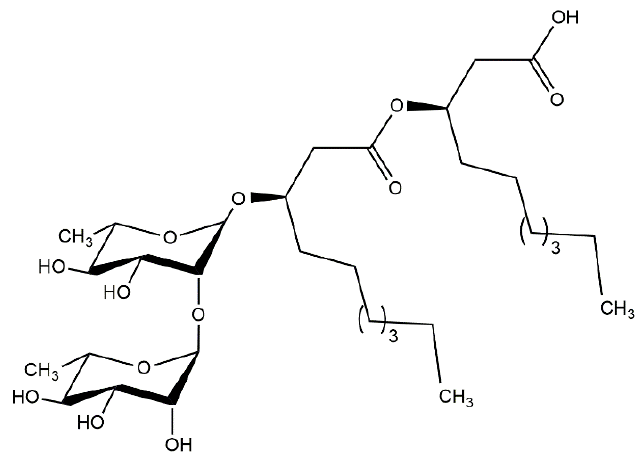
Figure 1. Main RL present in RLs mixture produced by Pseudomonas aeruginosa , here designated as di-RL